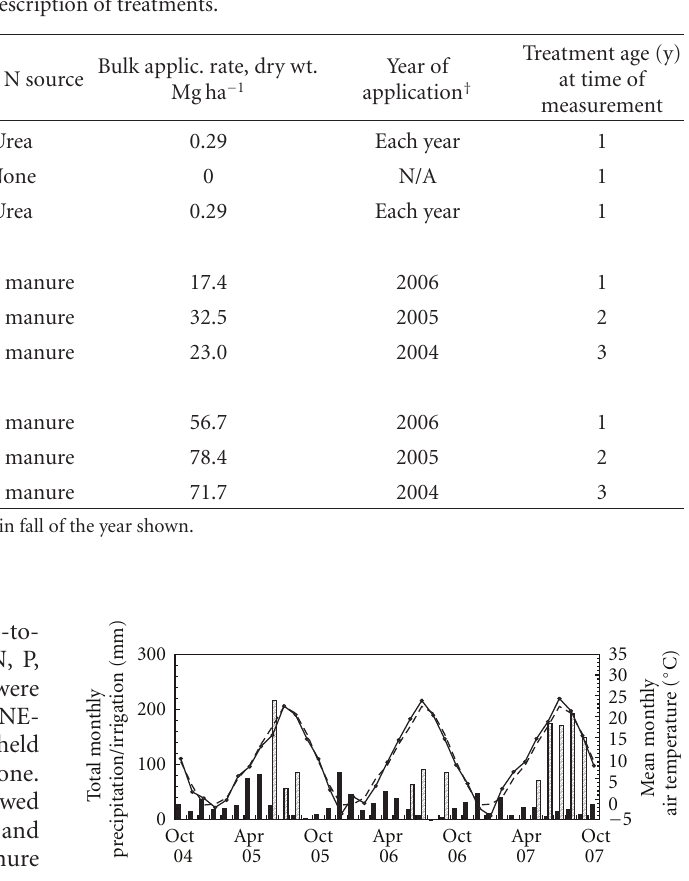
Table 1: Description of treatments.